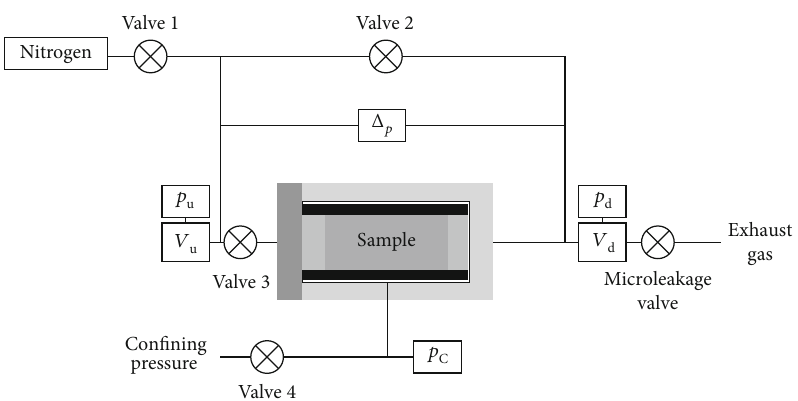
Figure 3: Schematic diagram of the pulse